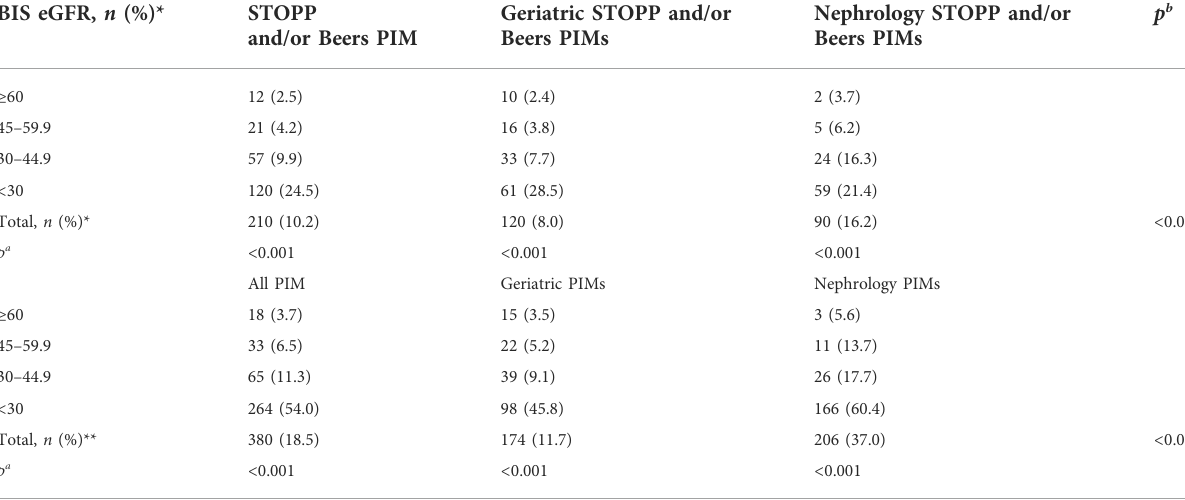
TABLE 3 Prevalence of STOPP and/or Beers PIMs and cumulative PIMs in the study population and different settings.